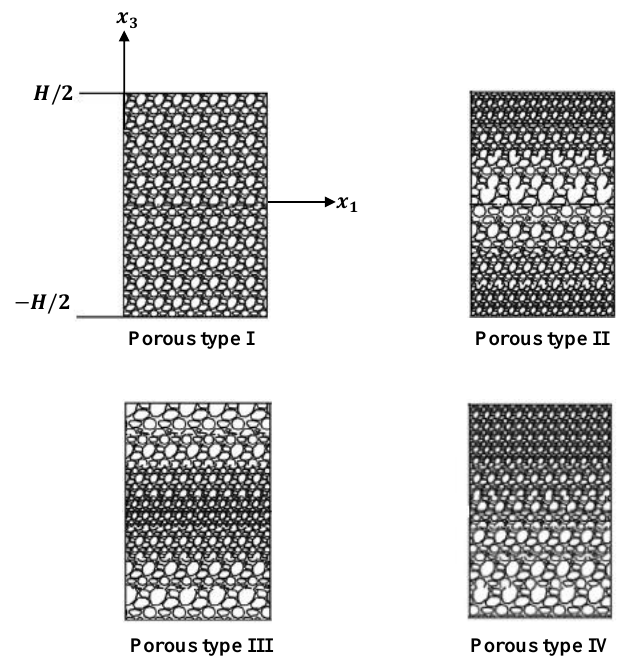
Figure 2. Porosity distribution